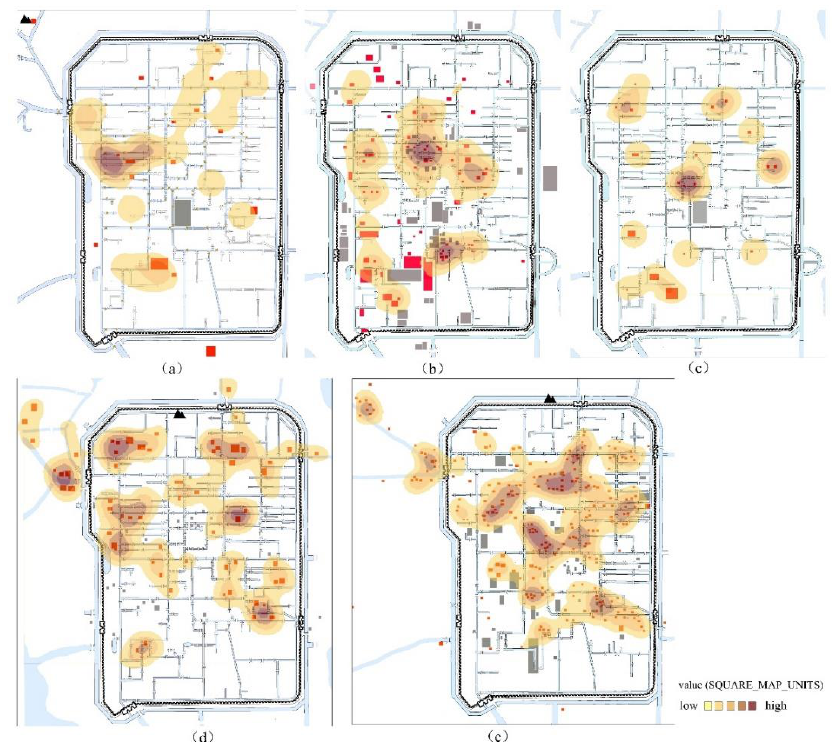
Figure 4. The result of kernel density analysis of Suzhou private gardens in different dynasties. ( a ) Tang Dynasty and the period of Ng- Yuih Kingdom (Search radius = 50). ( b ) Song Dynasty (Search radius = 150). ( c ) Yuan Dynasty (Search radius = 50). ( d ) Ming Dynasty (Search radius = 150). ( e ) Qing Dynasty (Search radius = 250).